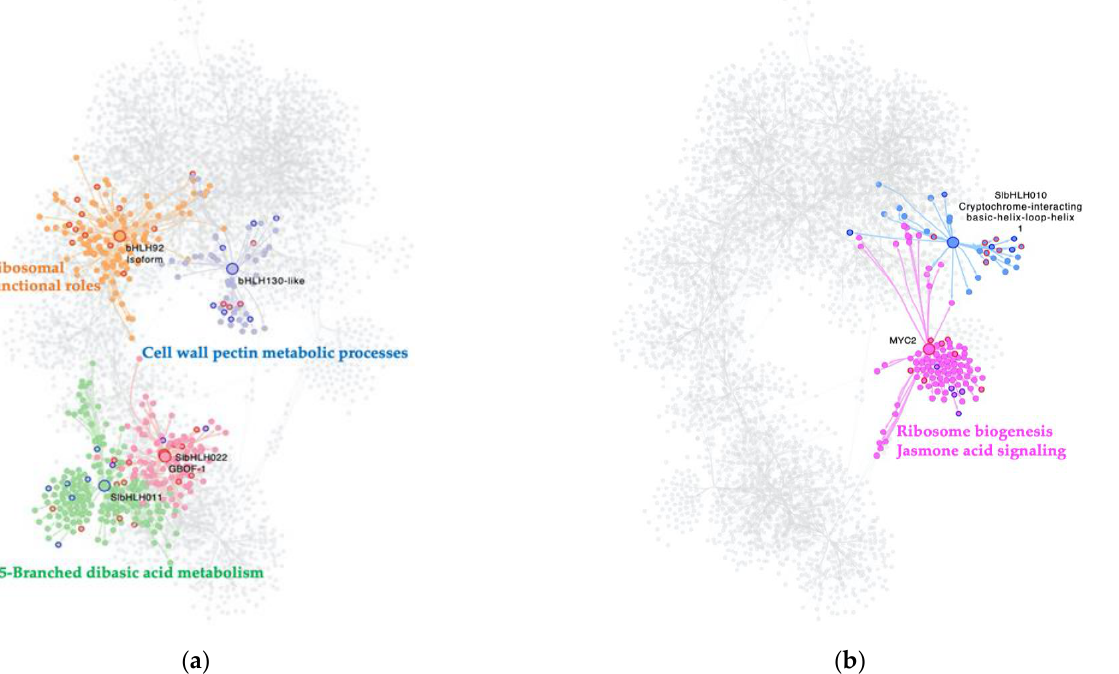
Figure 2. Interactome of the bHLH MTRs in the experimental conditions comparisons: ( a ) C. vs. S23 condition, ( b ): M. vs. S23 condition. Each node represents a gene, and the edges between nodes represent regulatory interactions between genes. The big, highlighted nodes with a specific color represent bHLH-MTRs and the colored perimeter of each MTR represents their NES value. Nodes of the same color surrounding these represent target genes regulated by an MTR, and the most differentially expressed genes in each regulon have colored perimeters: blue for downregulated, red for upregulated. Enriched biological processes of each regulon are presented in the same color as the regulon. In the comparison C. vs. S23 bHLH-MTRs are bHLH130-like (blue), bHLH92 (orange), SlbHLH011 (green), SlbHLH022 (cherry red), GBOF-1 (cherry red). Meanwhile, in the comparison M. vs. S23, bHLH-MTRs are MYC2 (pink) and SlbHLH010 (blue).